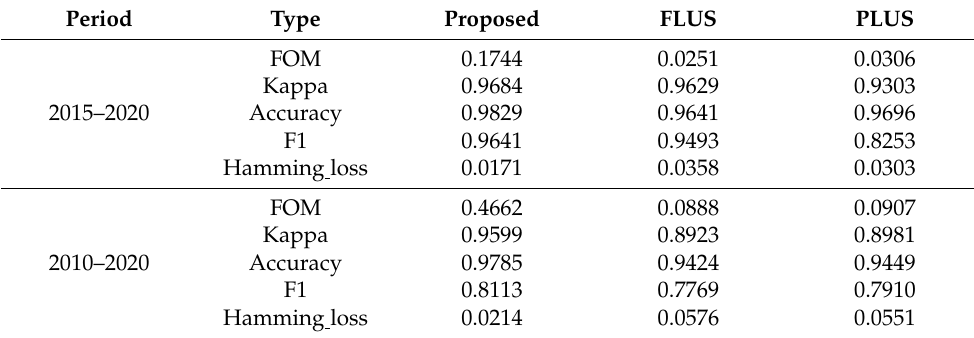
Table 6. The proposed model compared to PLUS model and FLUS